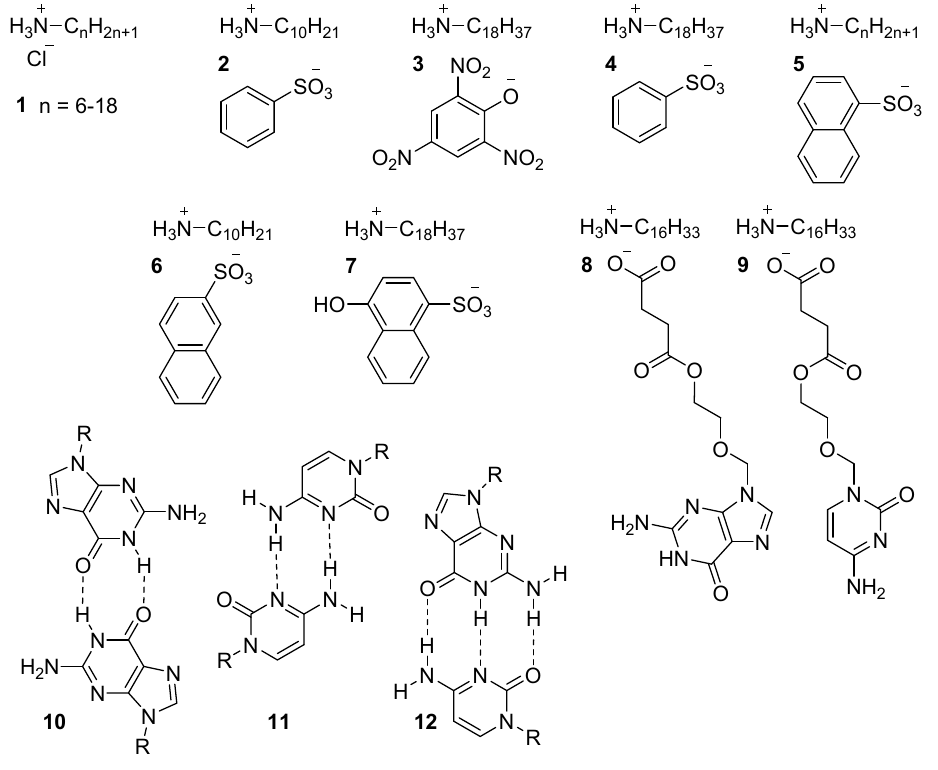
Figure 3. Protonated amine ILCs.